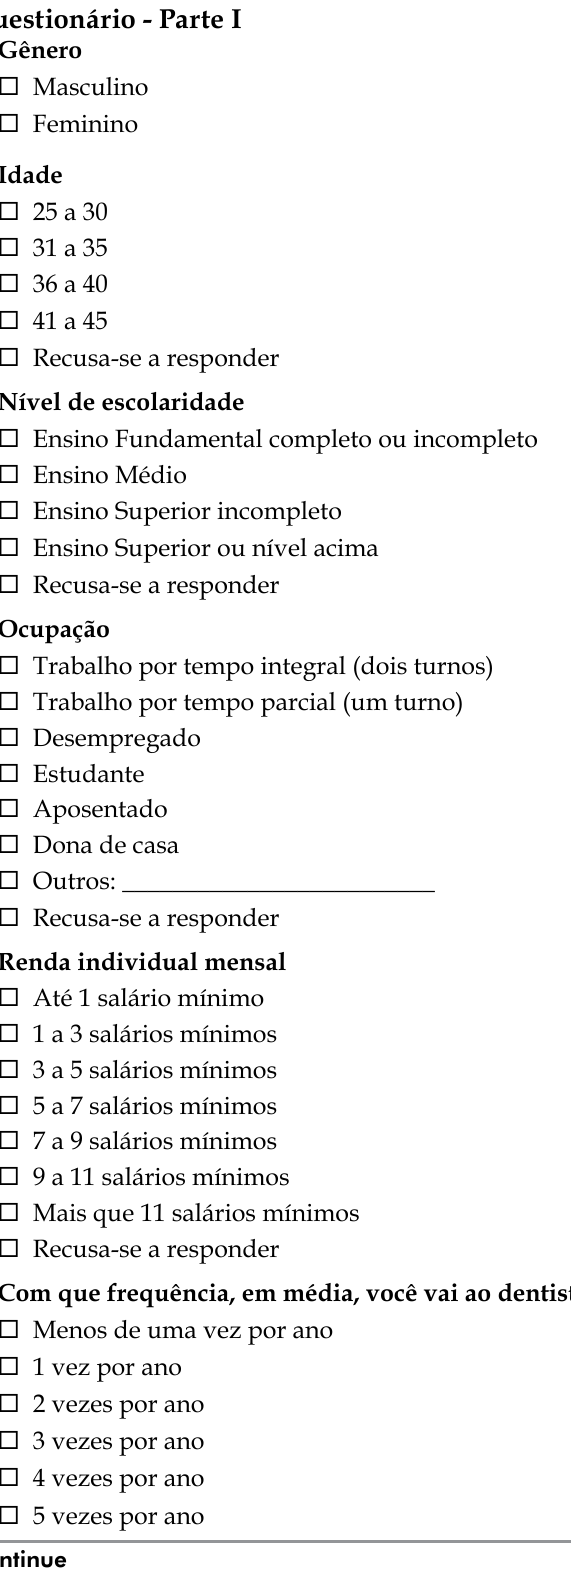
Figure. Translated and adapted version of